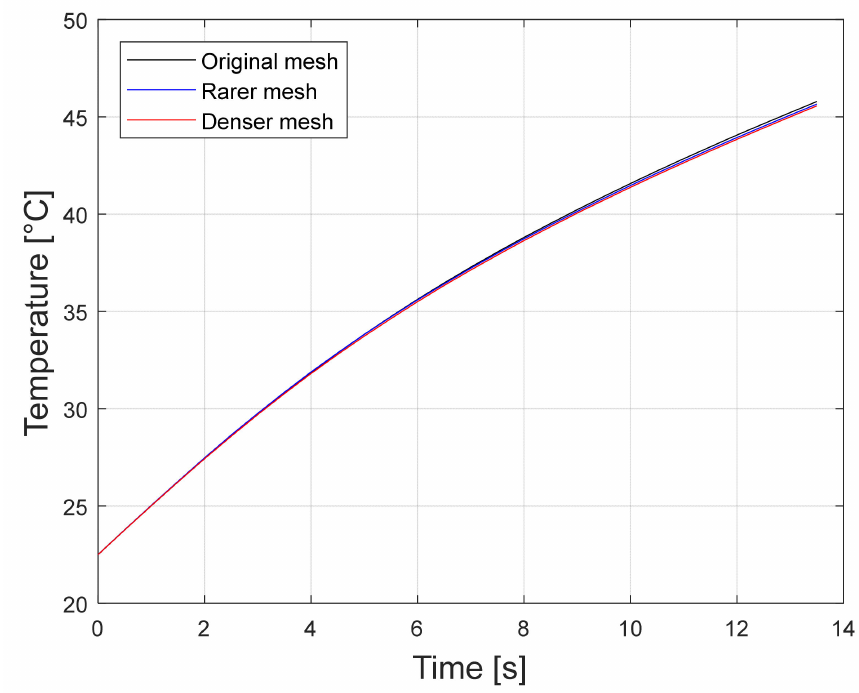
Figure 12. Comparison of the results between different mesh densities at field parameters of H = 7.83 kA/m and f = 281 kHz.